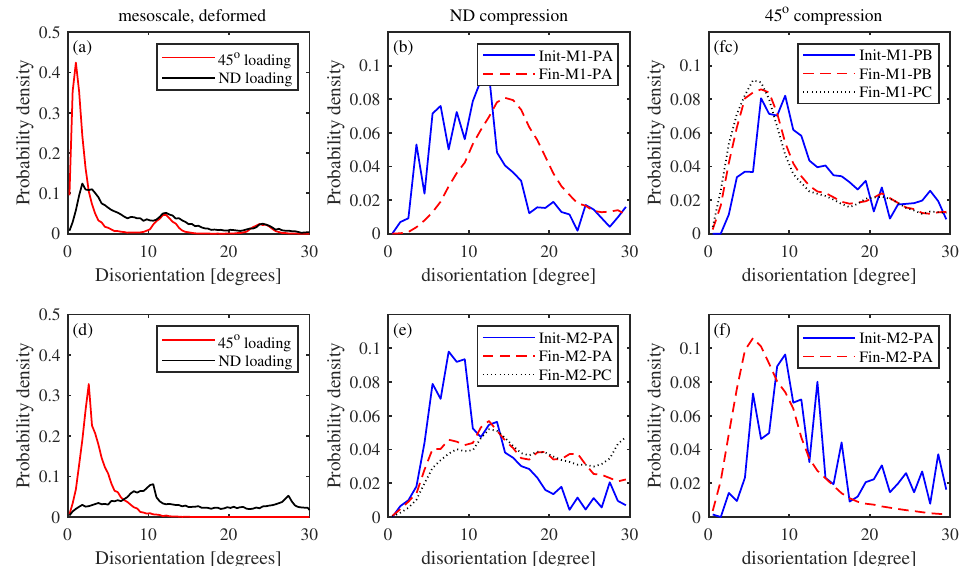
Figure 11. Disorientation with respect to mean orientation in MTR: Initial and final curves for ND compression, and initial and final curves for 45 ◦